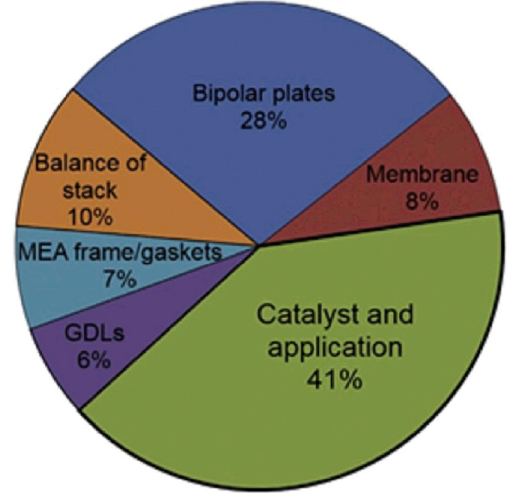
Fig. 1 Component cost breakdown at a production volume of 500,000 units/yr for the FC stack